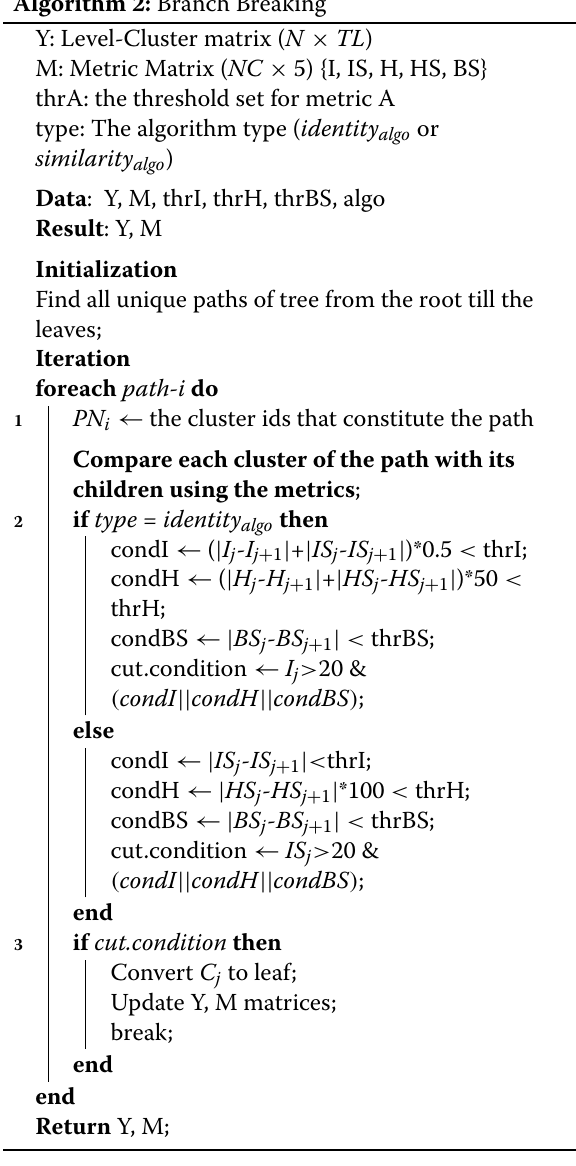
Algorithm 2: Branch